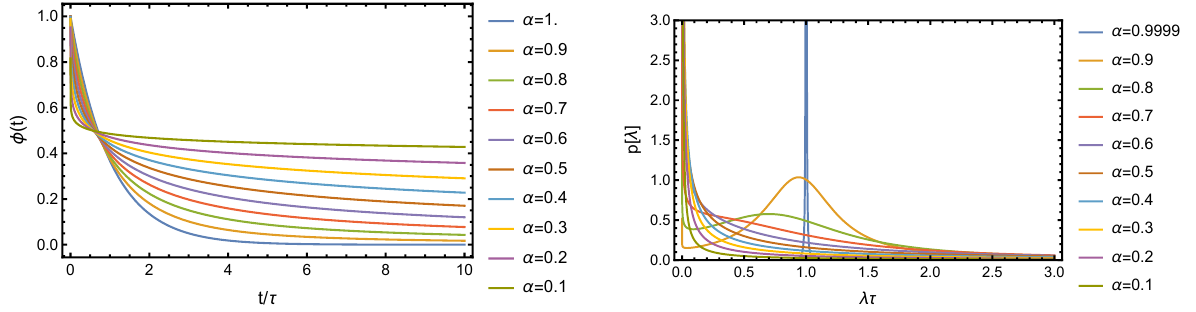
Figure 1. Left panel: Model relaxation function, E α ( − ( | t | /τ ) α ), for 0 < α ≤ 1. Right panel: The corresponding relaxation rate spectra defined by Eq.